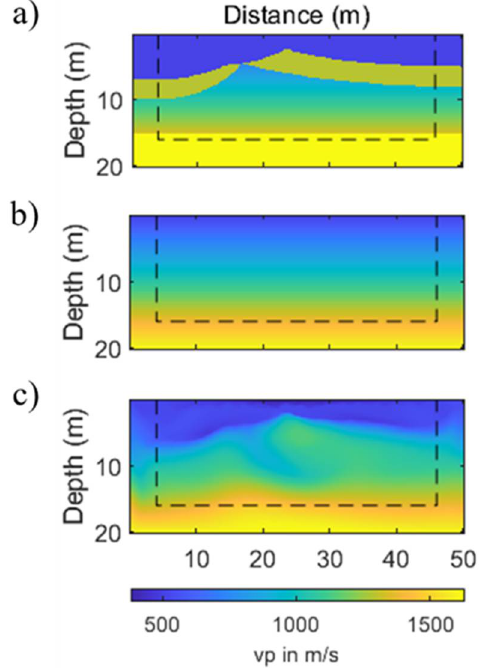
Figure 6. Multi-parameter synthetic example when using a high-frequency source signal: ( a ) the true P- wave velocity model for the calculation of the observed data, ( b ) the initial P- wave velocity model, and ( c ) the inverted P- wave velocity model. The CPML frame is marked by a thin black line.